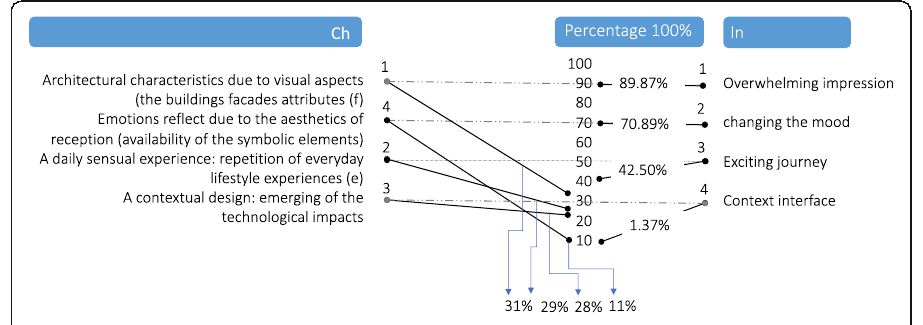
Fig. 10 The contradiction between the degree of importance between SMC and